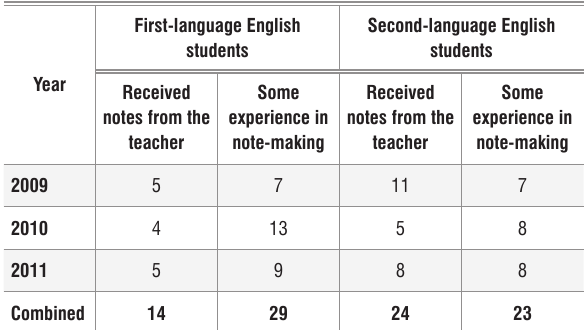
First- and second-language students’ note-making